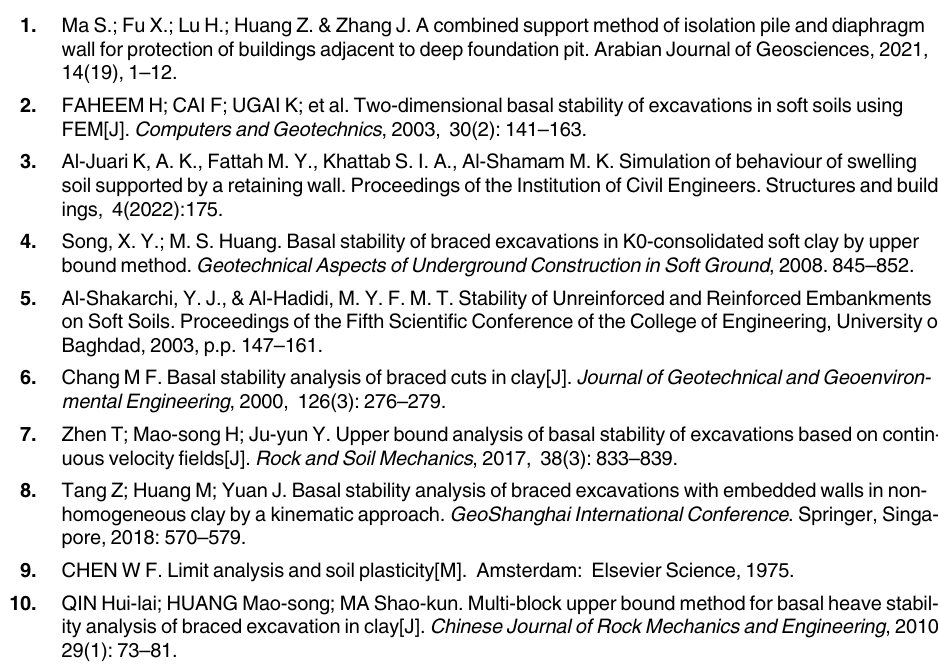
S5 Table. Relationship between the stability coefficient and e ( t = 9m). S6 Table. Relationship between the stability coefficient and e ( t = 15m). S7 Table. The stability coefficient with no isolation